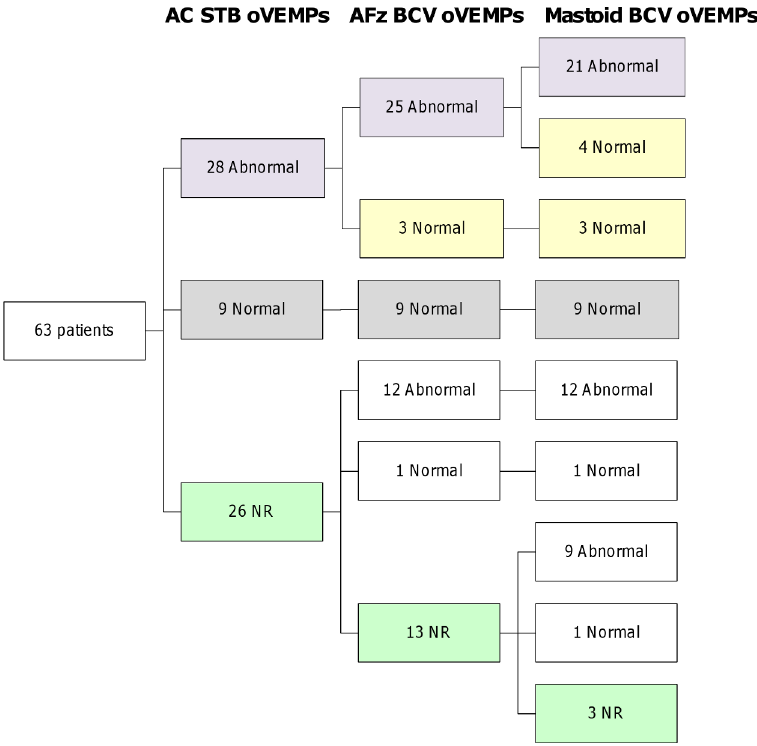
Figure 3. Flowchart showing the oVEMP results for non-operated VS patients (n=63). Results are presented according to the following test sequence: AC STB, AFz BCV and mastoid BCV. This sequence is optimal to provide reliable conclusions about the functional status of the inferior (mostly utricular) nerve in a minimum of time. Patients with normal ACS oVEMPs always exhibited normal AFz and normal mastoid oVEMPs (Figure 3, grey squares). Patients with abnormal oVEMPs also exhibited abnormal AFz (25 of 28 patients) and abnormal mastoid oVEMPs (21 of 28 patients) (Figure 3, purple squares). Abnormal ACS but normal BCV oVEMPs were observed in three of 28 patients for AFz and in seven of 28 patients for mastoid BCV (Figure 3, yellow squares). Among the 26 ACS NR patients, 13 were NR for AFz BCV and three were NR for mastoid BCV(green squares).